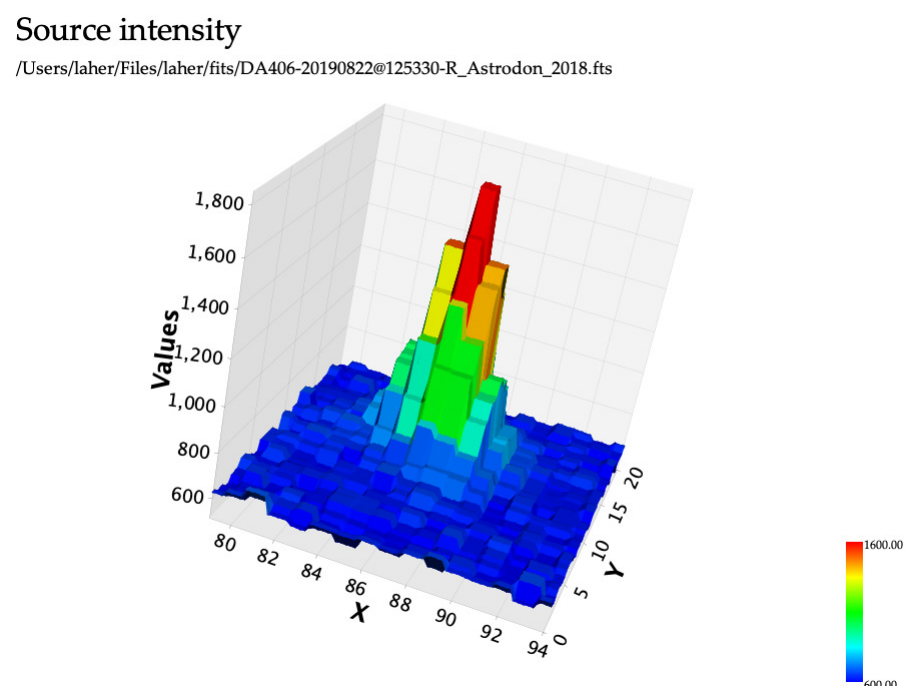
Figure 2. Example 3D surface plot of a source in a FITS image made by Thoth. In this case, the entire image consisting of 2048 × 2048 pixels is loaded into a Thoth table, but only the user-specified portion around the source is plotted. The 3D surface plot is displayed with the optional rainbow color scale. The 3D surface plots are interactive and can be rotated by dragging the mouse across the plot.